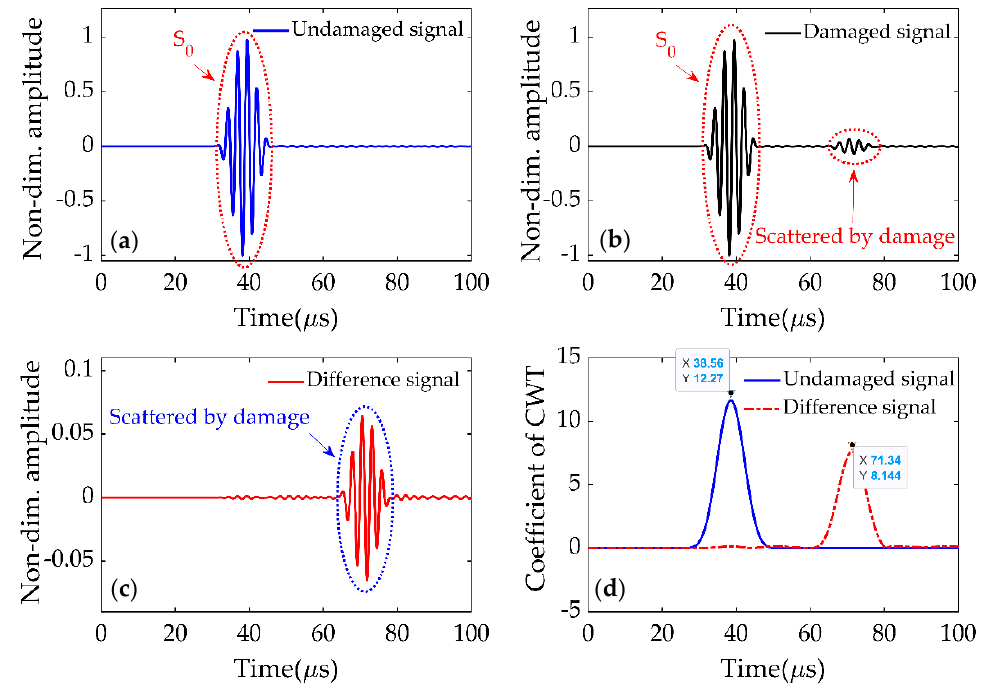
Figure 8. ( a ) Undamaged signal at P2. ( b ) Damaged signal at P2. ( c ) Difference between undamaged and damaged signals. ( d ) CWT of undamaged and difference signals.